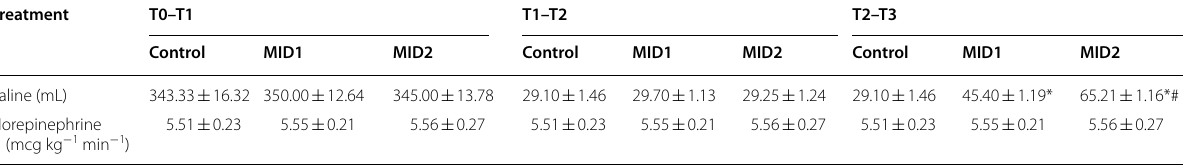
Table 2 Fluid and norepinephrine administration during the experiment